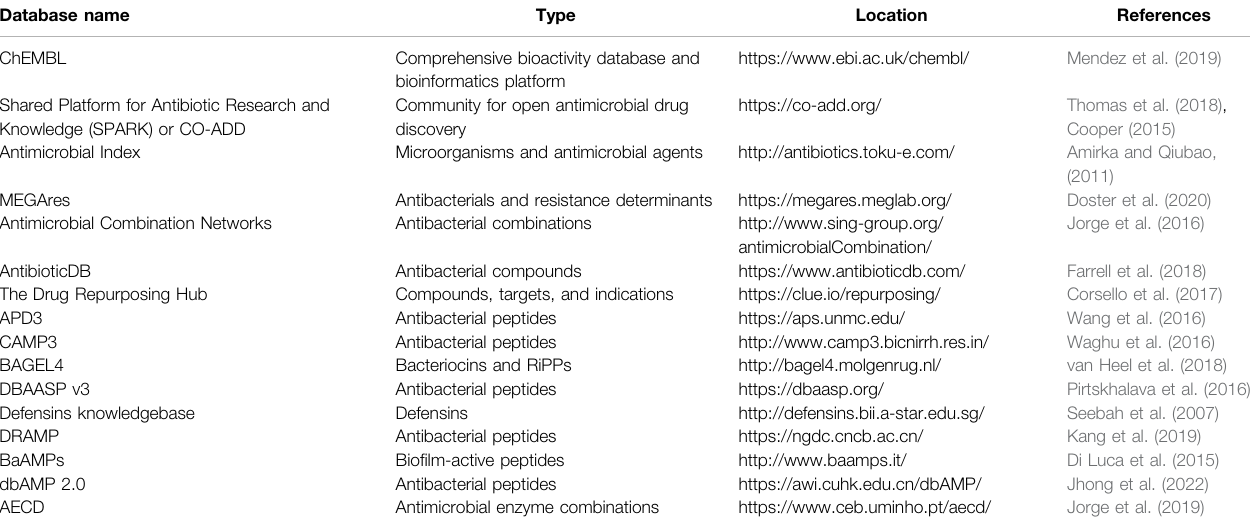
TABLE 1 | Currently available antibacterial compound and peptide databases suitable for in silico drug design